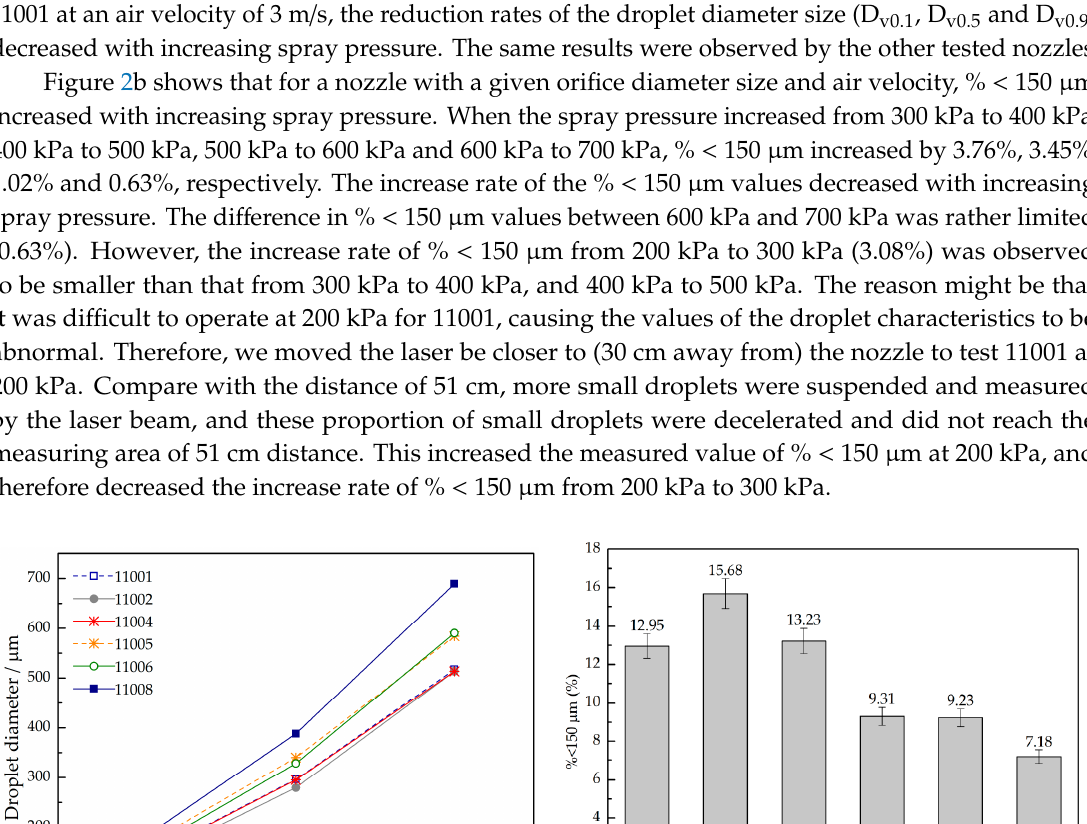
Table 5. Droplet size classification categories for air induction nozzles (AIN) based on the American Society of Agricultural and Biological Engineers (ASABE) classification standard S-572.1. VDM (D v0.5 ) is generally used for droplet size classification.